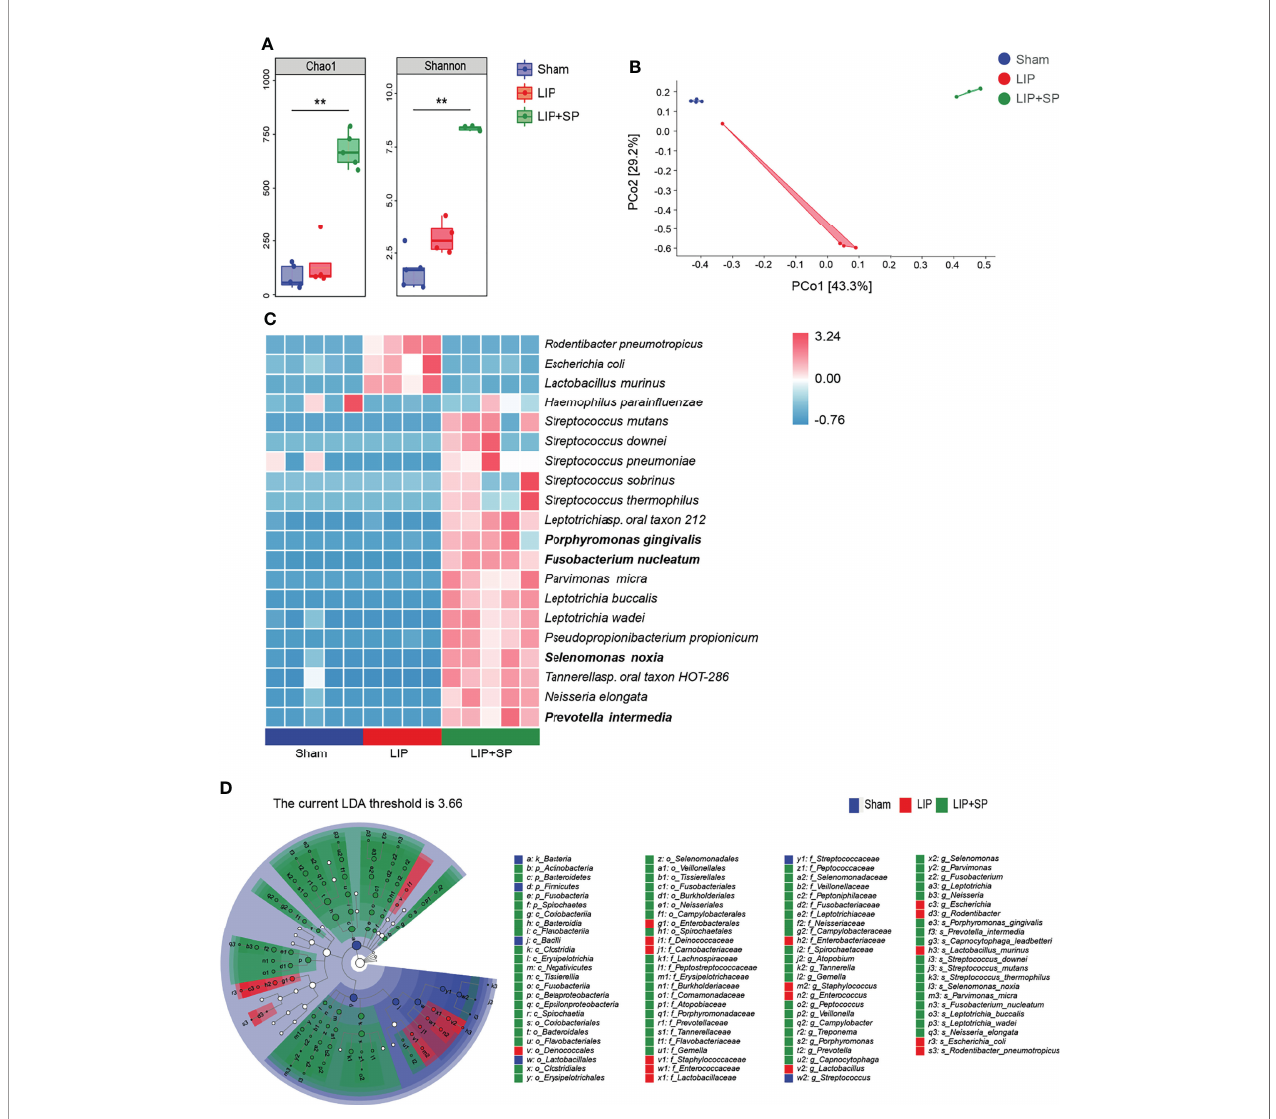
FIGURE 3 | Pathogenic bacteria of human periodontitis are enriched in the mouse saliva. Saliva bacteria from Sham, LIP, and LIP + SP group mice were analyzed using 16S rRNA gene sequencing. (A) a -diversity of saliva bacteria assessed by Chao1 and Shannon indices. (B) b -diversity of saliva bacteria at species level, assessed by principal coordinate analysis (PCoA) based on Bray – Curtis distance. (C) The heat map of the relative abundance of the top 20 most abundant bacteria species in mouse saliva. (D) Taxonomic cladogram of saliva bacteria using LEfSe (LDA = 3.65). LDA, Linear Discriminant Analysis. The values represent means ± SEM (n = 5:4:5). **P <